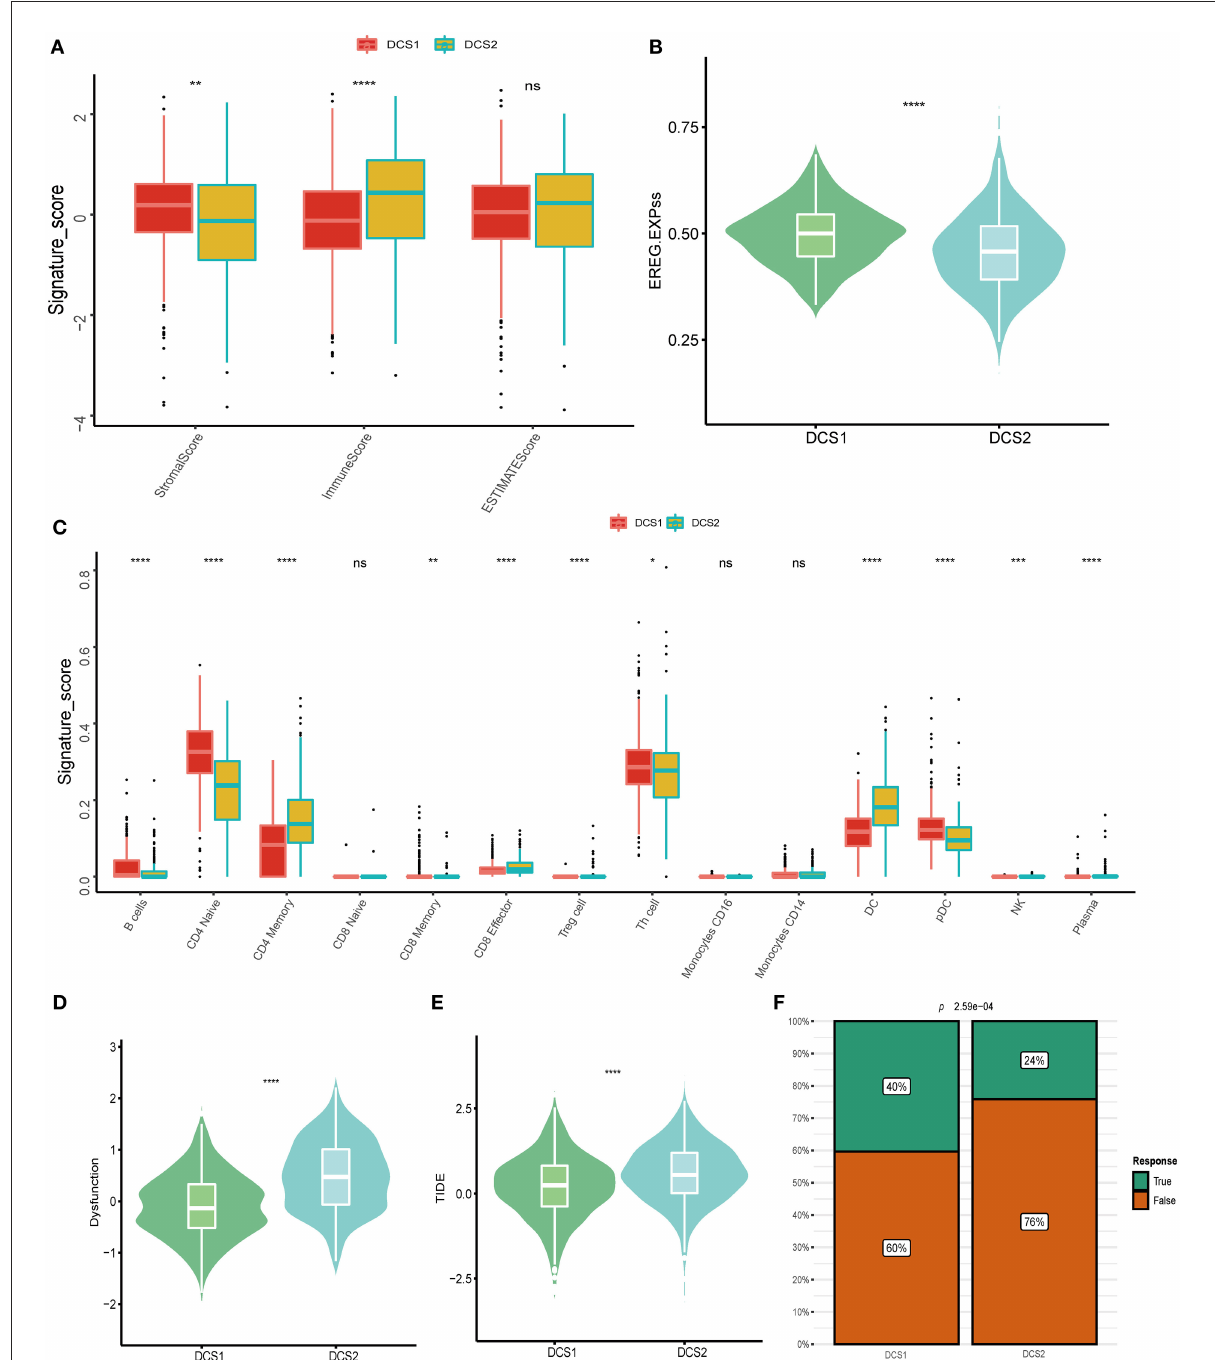
FIGURE4 Landscapes of specific immune components and immune function scores. (A) Stromal, immune and ESTIMATE scores difference between subtypes. (B,C) EGER.EXPss and immune signature difference between DCS1 and DCS2. (D,E) Immune dysfunction and TIDE score between subtypes. (F) Difference of immune therapy response of DCS1 and